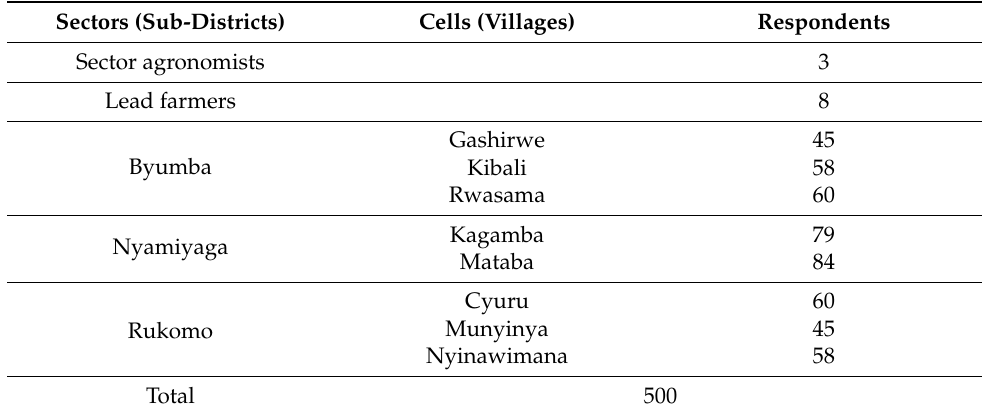
Figure 1. Study locations in the Gicumbi district, Rwanda. Map source: Adapted from Gicumbi District [46]. Table 1. Respondents distribution.